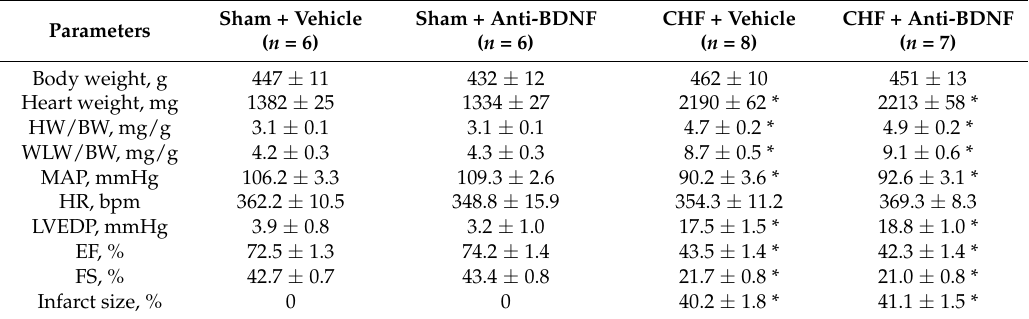
Table 1. Hemodynamic and morphological data in sham and chronic heart failure (CHF) rats.